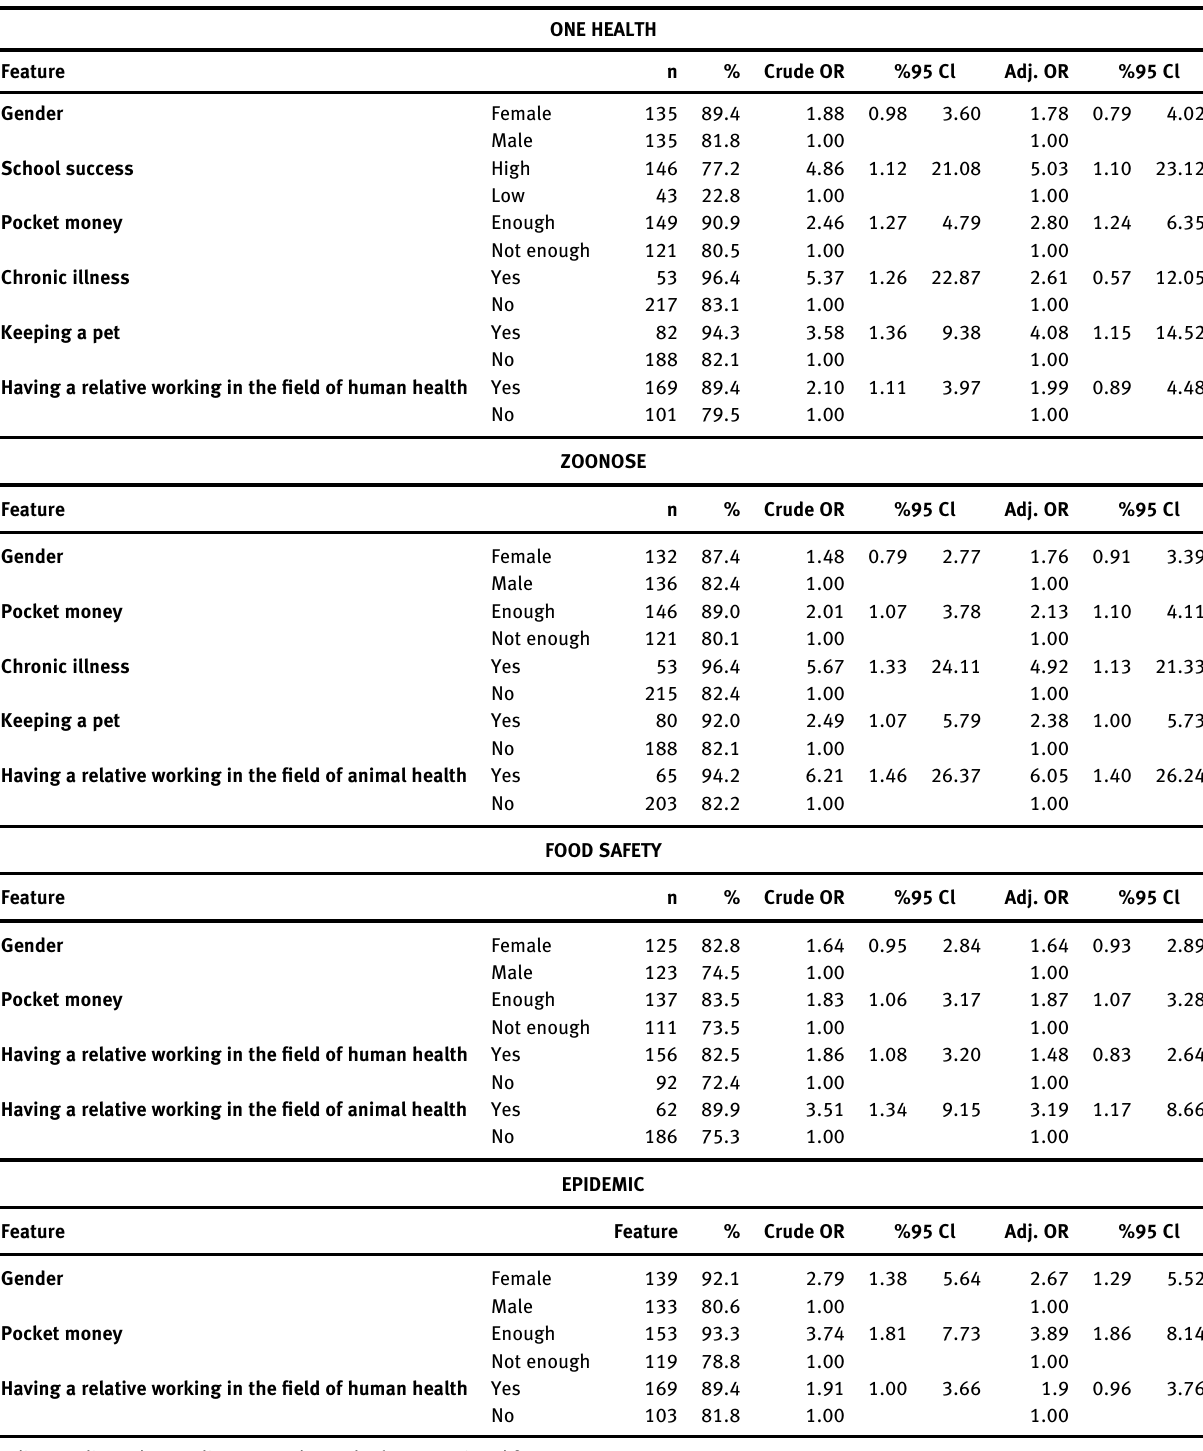
Table  : Factors associated with the attitude towards ‘ One Health ’ and its